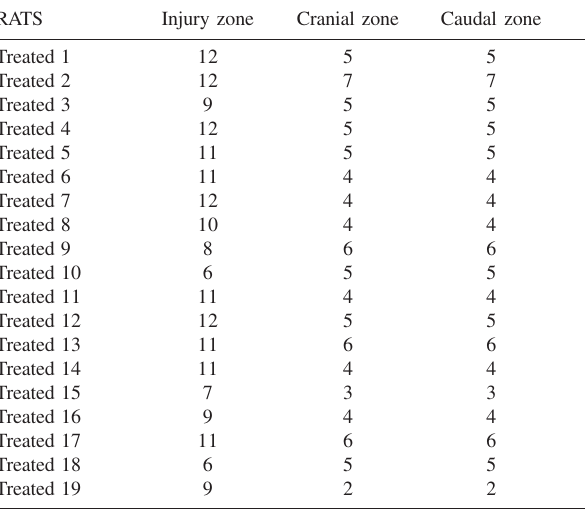
Figure 3 - Comparative Histological Score Control vs NT-3